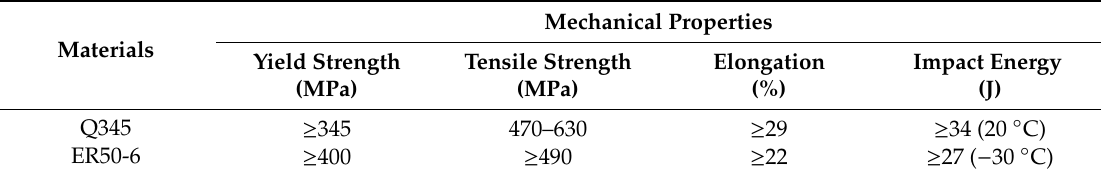
Table 2. The mechanical properties of the base metal and welding wire.